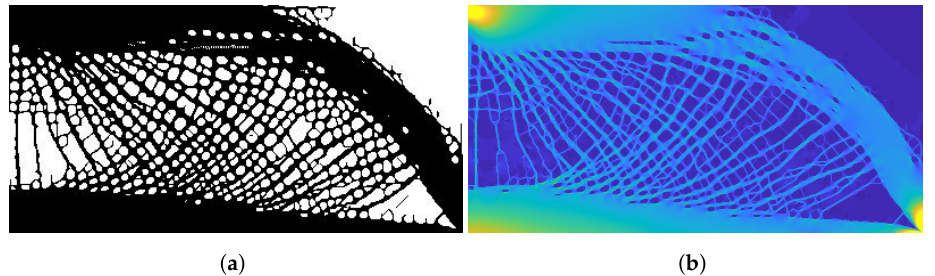
Figure 10. Effects of the stress-based post-processing filter ( a ) before and ( b ) the equivalent von Mises stress result. The post-processed result is found in Figure